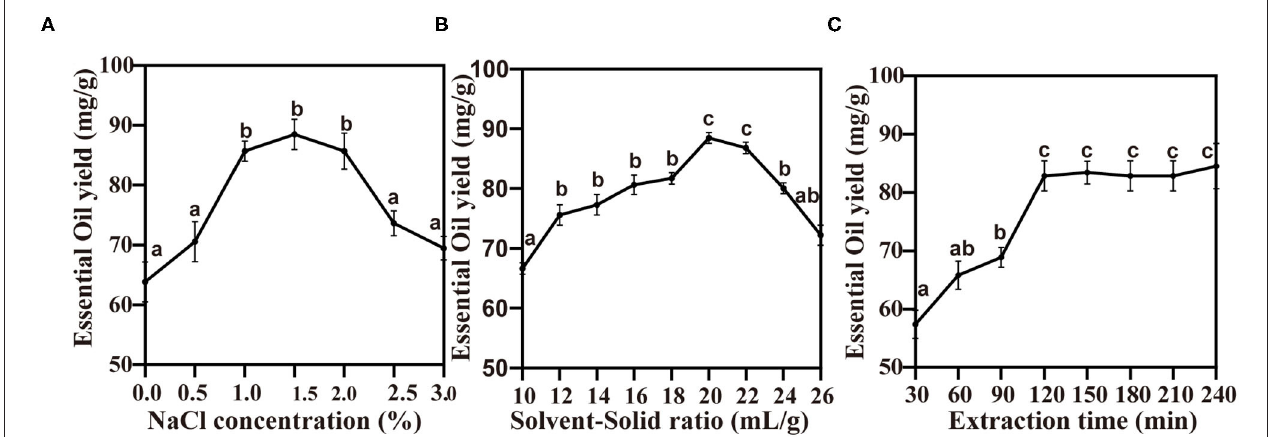
FIGURE 2 | The effect of the traditional hydrodistillation extraction on the TCEO yield. (A) The concentration of sodium chloride on the TCEO yield; (B) the solvent-solid ratio on the TCEO yield; (C) the extraction time on the TCEO yield. Values with the same letter are not significantly different p < 0.05 according to ANOVA.